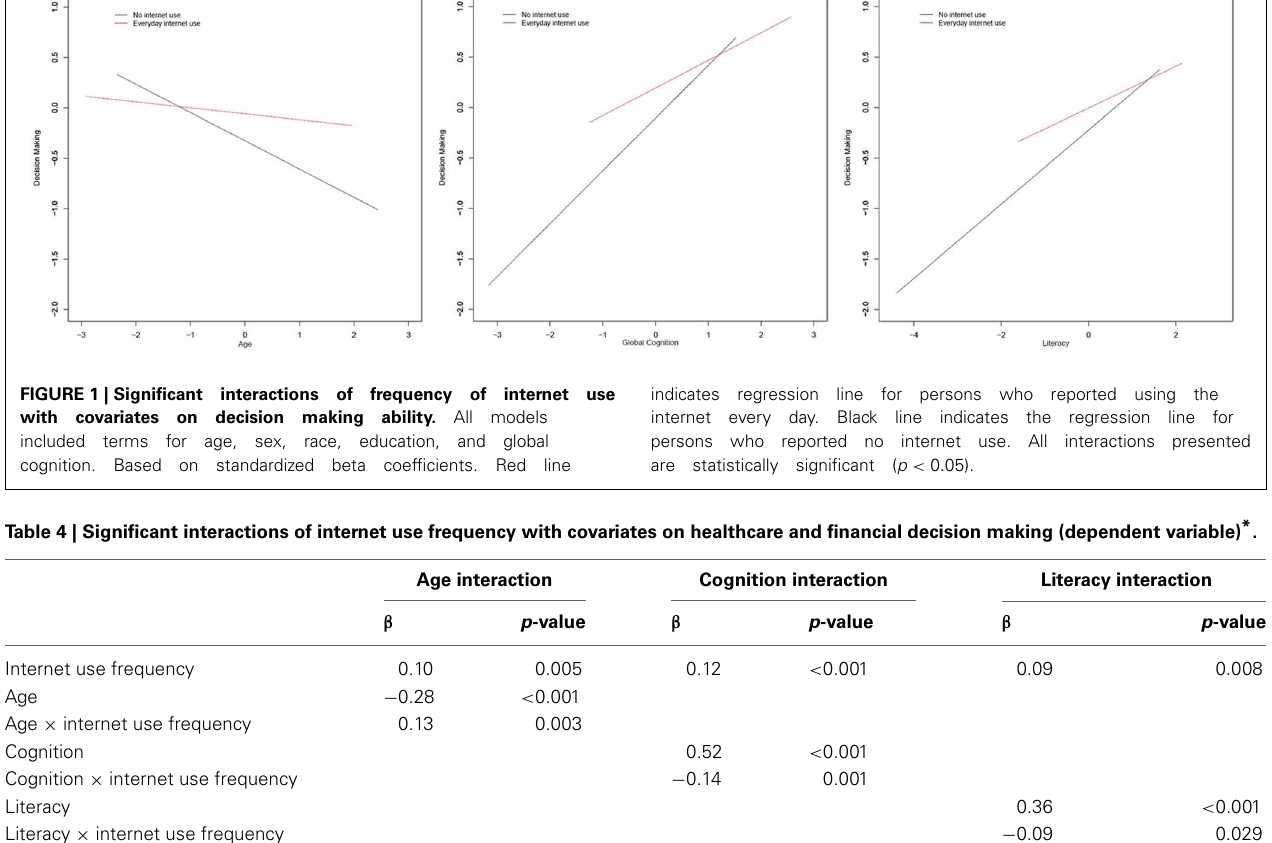
* β = standardized Beta coefficient (change in decision making score associated with a one standard deviation increase in independent variable). All models included terms for age, sex, education, race, and global cognition; only terms for variables in interaction tested are